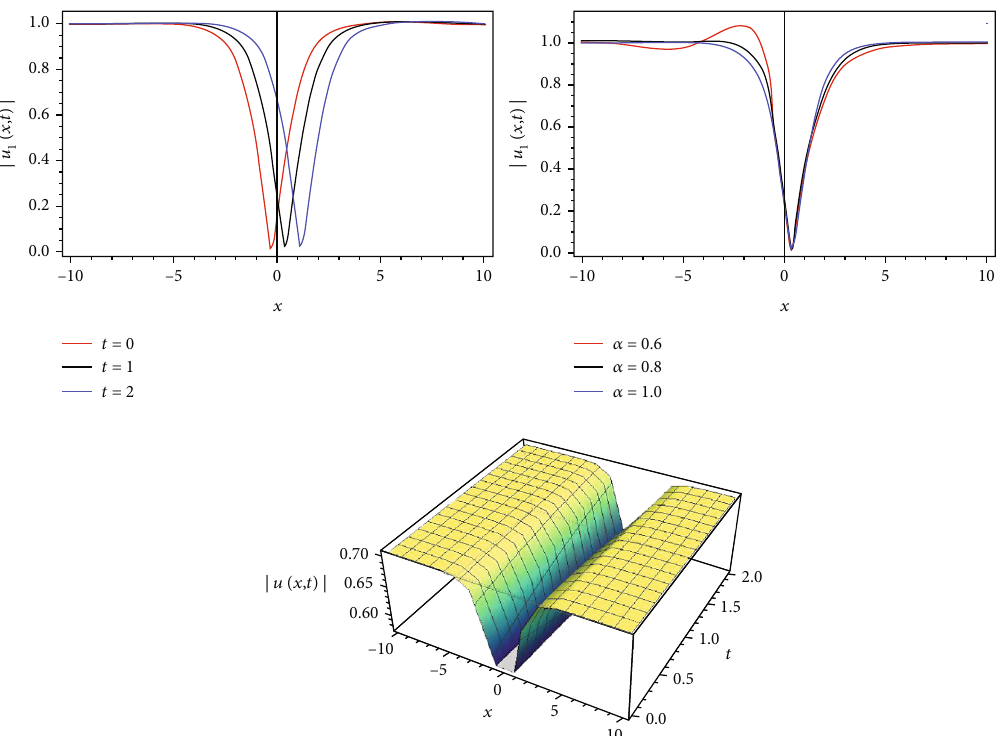
Figure 1: 2D and 3D graphics of Case 1 for hyperbolic traveling wave solution (28) at f α = 0 : 6, k = 0 : 7, q = 1, s = 1, C = − 1, c = 0 : 5 g :